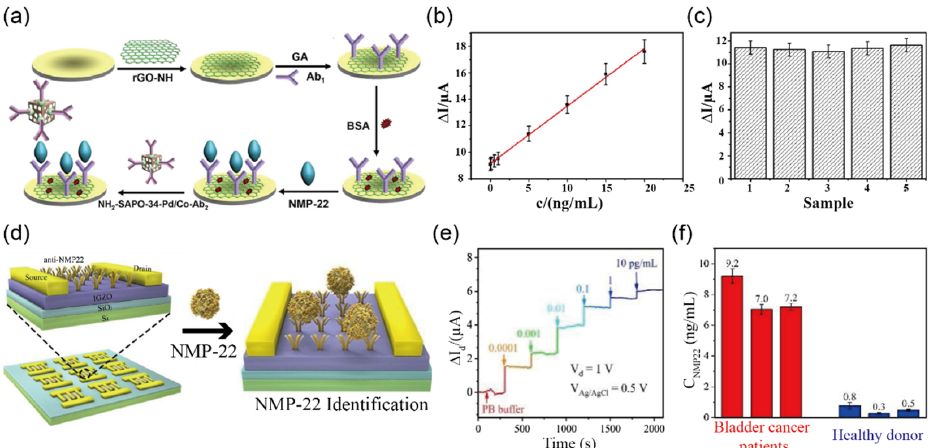
Figure 10. Selective detection of biomarkers for diagnosis of bladder cancer in clinical samples ( a ) Illustration representing the electrochemical mechanism for detecting NMP-22 relying on NH 2 -SAPO-34-Pd/Co-Ab 2 ( b ) Linear responses of the immunosensor with NMP-22 concentrations ranging from 0.001 to 20 ng/mL; LOD and correlation coefficients are 0.33 pg/mL and 0.998, respectively. ( c ) Evaluation of the selectivity of the immunosensor toward NMP-22 (5 ng/mL) (1) solutions containing 500 ng/mL of interfering substances such as bovine serum albumin (2), vitamin C (3), trioxypurine (4), and glucose (5). Error bar = RSD ( n = 5). (Reprinted with permission from [46]; copyright 2016 NATURE.) ( d ) For bladder cancer detection, schematic diagram of the IGZO-FET biosensor array functionalized by anti-NMP-22 ( e ) Real-time response of IGZO-FET toward different concentra- tions of NMP-22 from 0.0001 to 10 pg/mL. The drain current (I D ) was measured at V DS = 1 V and V GS = 0.5 V ( f ) Evaluation of sensing performance toward different concentrations of NMP-22 in response to clinical urine samples from bladder cancer patients and healthy donors (reprinted with permission from Ref. [47]; copyright 2020,